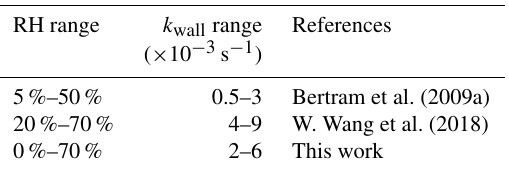
Figure 9. The dependence of the pseudo-first-order wall loss coef- ficient ( k wall ) on N 2 O 5 in the FEP-coated aerosol flow tube. Table 2. Summary of the k wall of N 2 O 5 for the existing aerosol flow tube deployed in field campaigns.